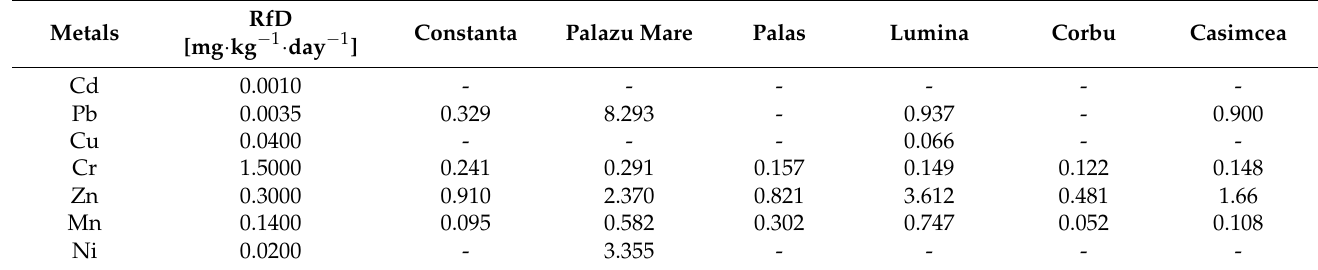
Table 7. Risk index values for the studied